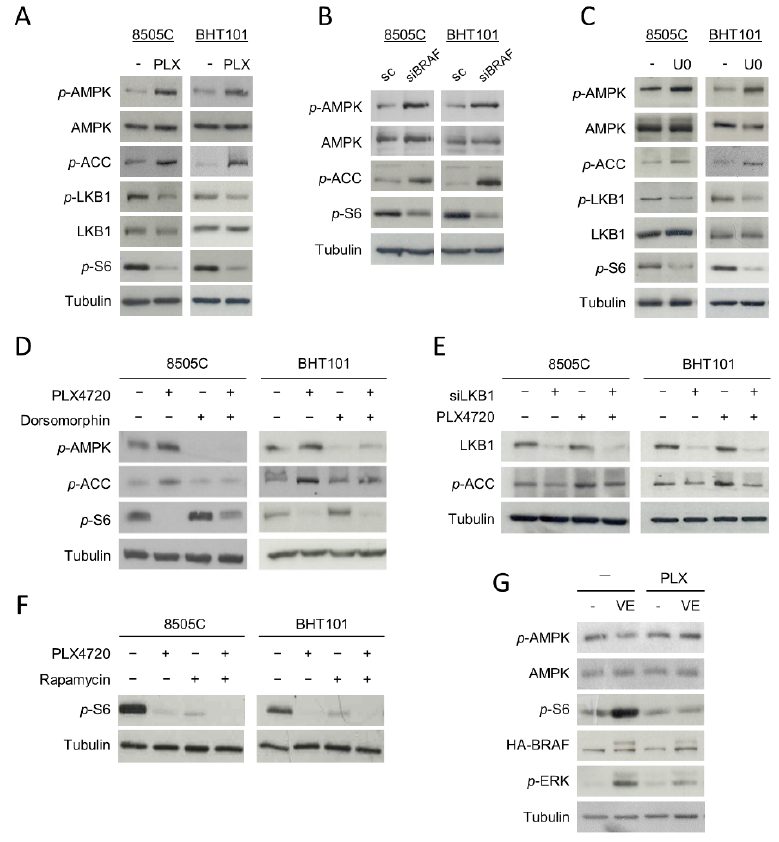
Figure 2. Inhibition of V600E BRAF activates the AMPK pathway and inhibits mTOR in thyroid cancer cells. Phosphorylation levels of AMPK ( p -AMPK), ACC ( p -ACC), LKB1 ( p -LKB1) and S6 ( p -S6), together with total protein levels of AMPK and LKB1 in 8505C and BHT101 cells treated with DMSO (-) or PLX4720 (PLX) ( A ) or U0126 (U0) ( C ) for 24 h. ( B ) p -AMPK, p -ACC, p -S6 and total AMPK levels in cells transfected with a scrambled oligo control (sc) or a specific siRNA for BRAF (siBRAF) for 72 h. ( D ) p -AMPK, p -ACC and p -S6 expression levels in cells incubated with DMSO or PLX4720, alone or with Dorsomorphin, for 24 h. ( E ) Expression of LKB1 and p -ACC in cells transfected with an oligo control or specific siRNA for LKB1 (siLKB1) for 48 h, and then incubated in the absence or presence of PLX4720 for 24 h. ( F ) p -S6 levels in cells incubated with DMSO or PLX4720, in the absence or presence of Rapamycin, for 24 h. ( G ) Levels of p -AMPK, AMPK, p -S6, HA-BRAF and phosphorylated ERK ( p -ERK) in both WRO-mock (-) and WRO-VE (VE) cells treated with DMSO or PLX4720 for 24 h. For each experiment, membranes were reprobed with anti- β -Tubulin as a loading control. Blots are representative of experiments performed three times with similar results.